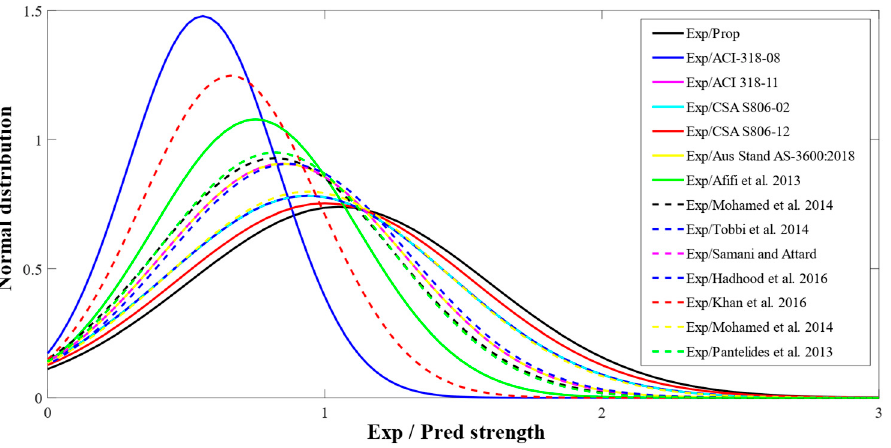
Figure 5. Normal distribution of testing to estimated strengths of GFRP-reinforced columns at- tained from various models. from various